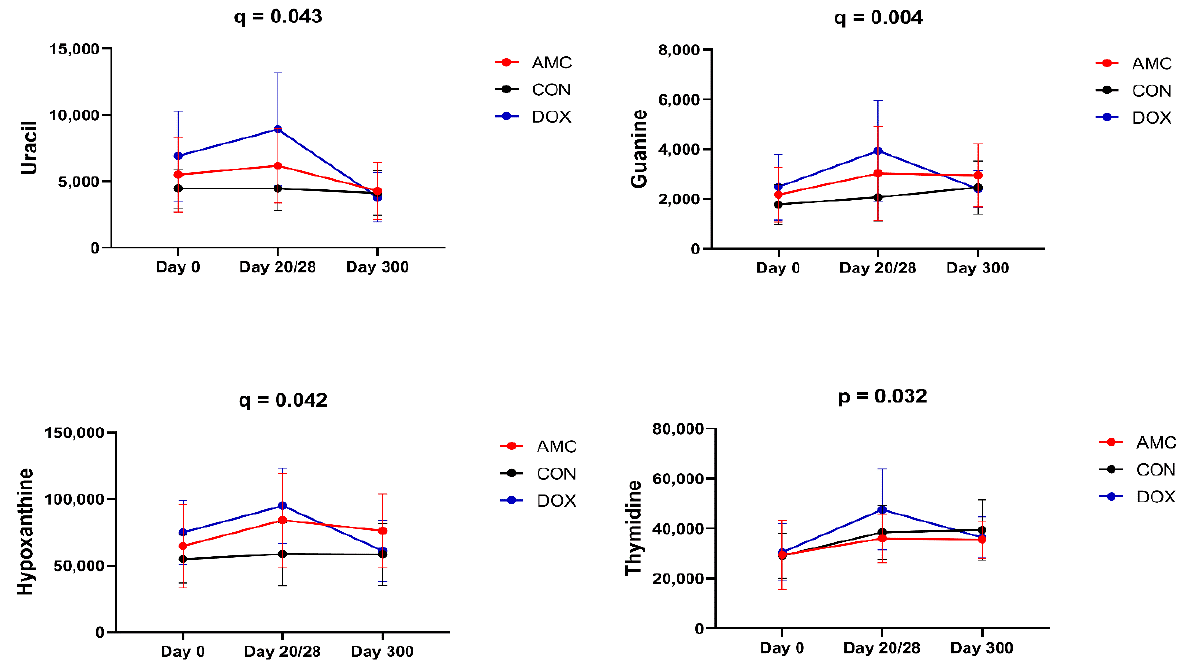
Figure 4. Changes in the abundance of serum metabolites that significantly differed between cats of the DOX and those of the CON group on day 20/28 (uracil, guanine, hypoxanthine) and from day 0 to day 28 within cats of the DOX group (thymidine). Means and standard deviations are